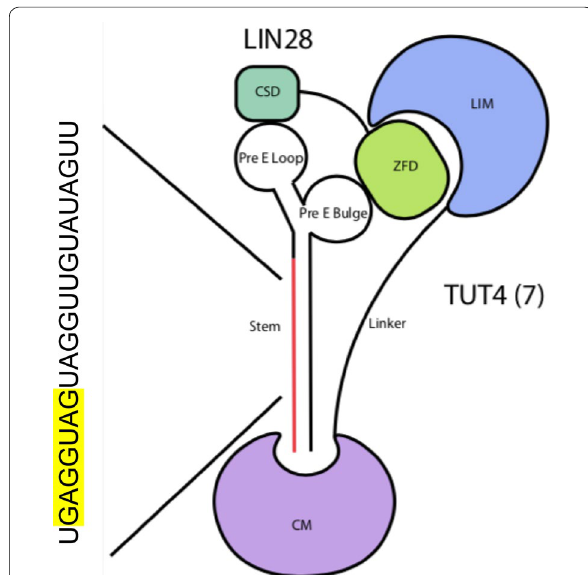
Fig. 1 LIN28/TUT4(7) let - 7 binding during post-transcriptional processing. Modified from Nam et al. and Faehnle et al. [111, 112]. CSD and ZFD are abbreviations for cold shock domain and zinc finger domain of LIN28 respectively. LIM and CM are abbreviations of LIN28 interactive module and catalytic module of TUT4(7) respectively.